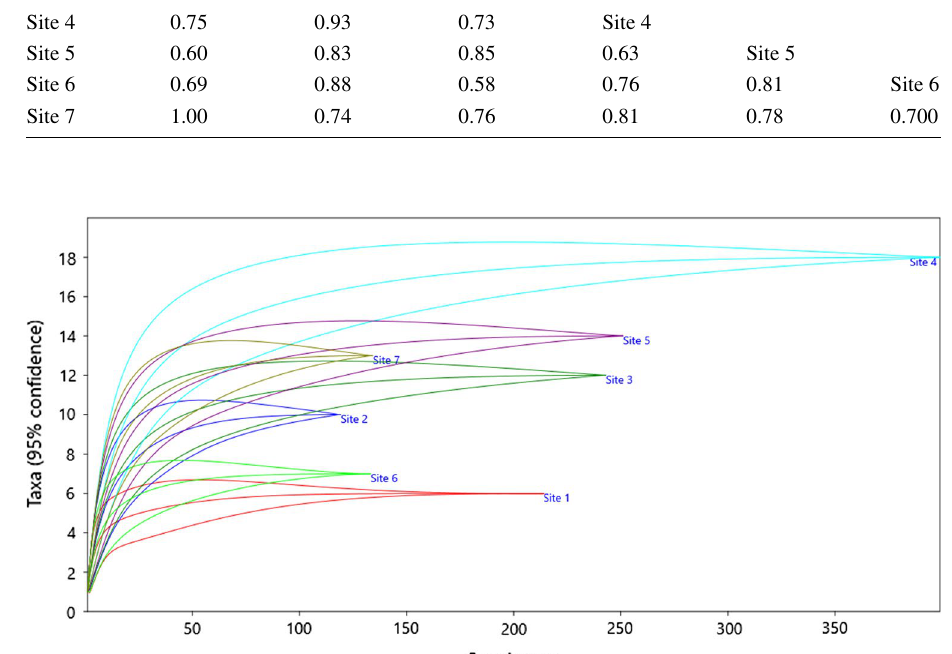
Table 3 Whittaker beta diversity (B w ) within seven study sites